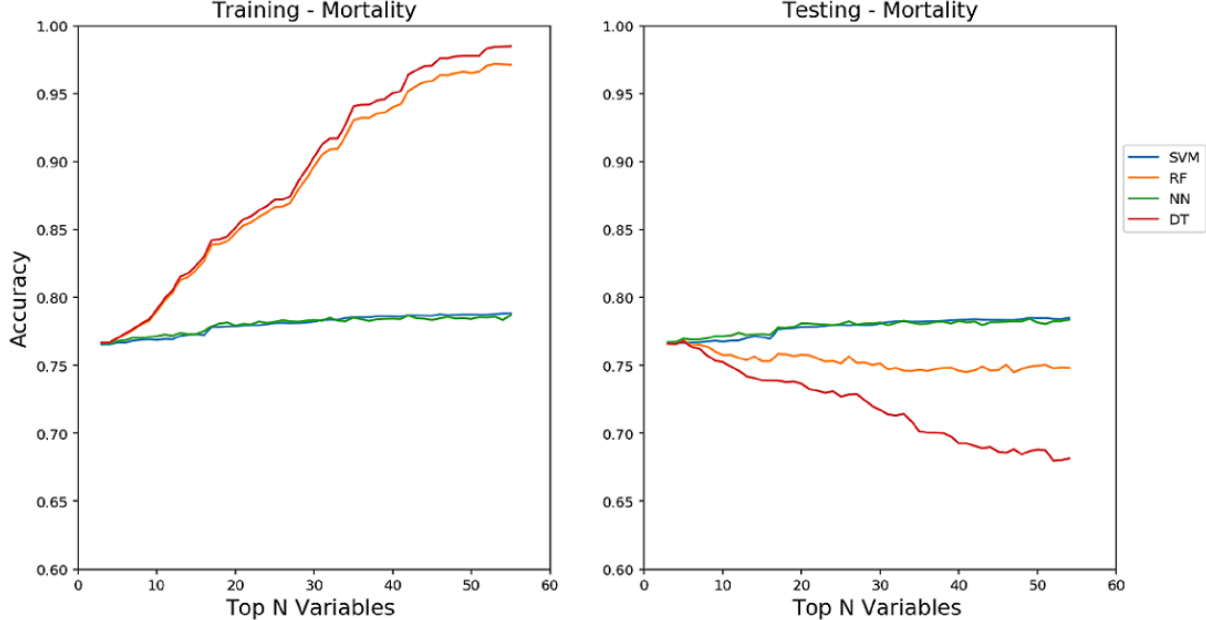
Figure 3. Train accuracy (left) and test accuracy (right) for mortality data without performing any parameter tuning and using all the feature subsets (from top 3 to top 58 feature subsets). The left plot shows that random forest and decision tree overfit the training data, which poorly generalize on the test data as the number of features increase.